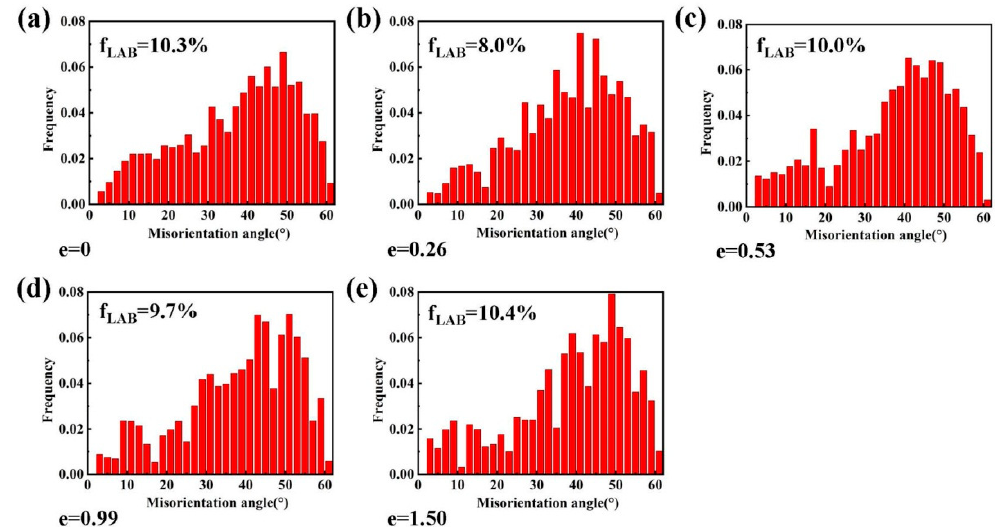
Figure 4. The grain boundary misorientation distribution images after superplastic deformation at 490 °C and 2 × 10 − 4 s − 1 .